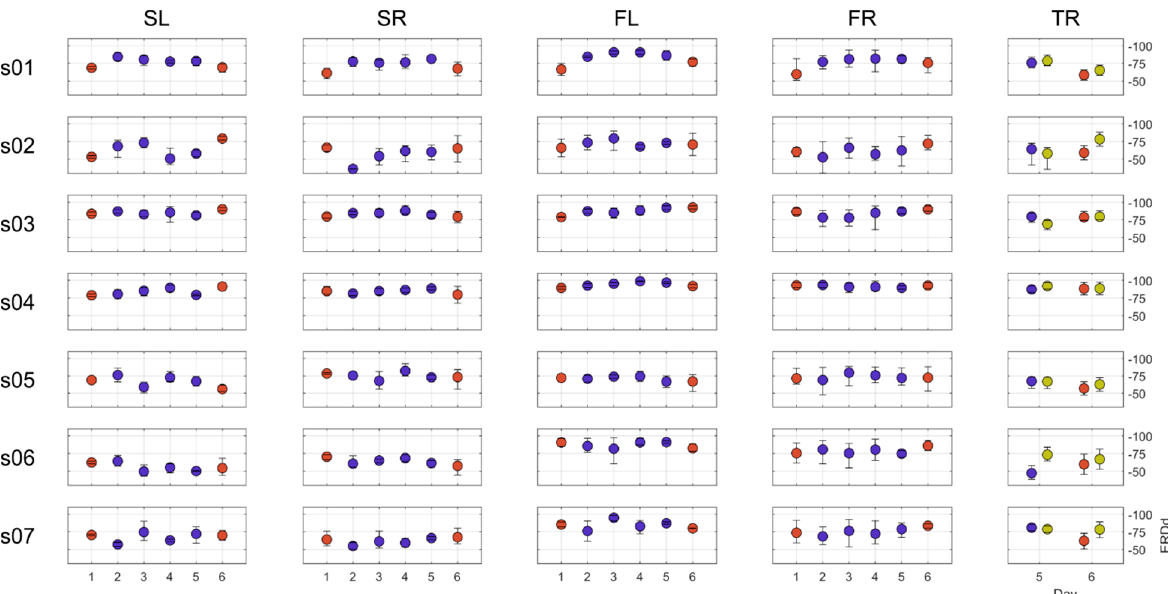
Figure 3. ERDd values corresponding to different motor imagery conditions for six experimental days. Event-related desynchronization strength measured using the ERDd score (OY axis); each point represents the mean value across all runs during a particular experimental day (OX axis), and error bars correspond to min–max range. For Days 1 and 6, only feedbacked runs were taken. Columns are motor imagery conditions: SL(R)—left (right) shoulder movement, FL(R)—right hand finger movement, TR—right hand thumb swipe. Color of the data point corresponds to the feedback condition: red—continuous visual feedback, blue—no feedback (static pictogram stimulus), and green—no feedback (continuous video stimulus).